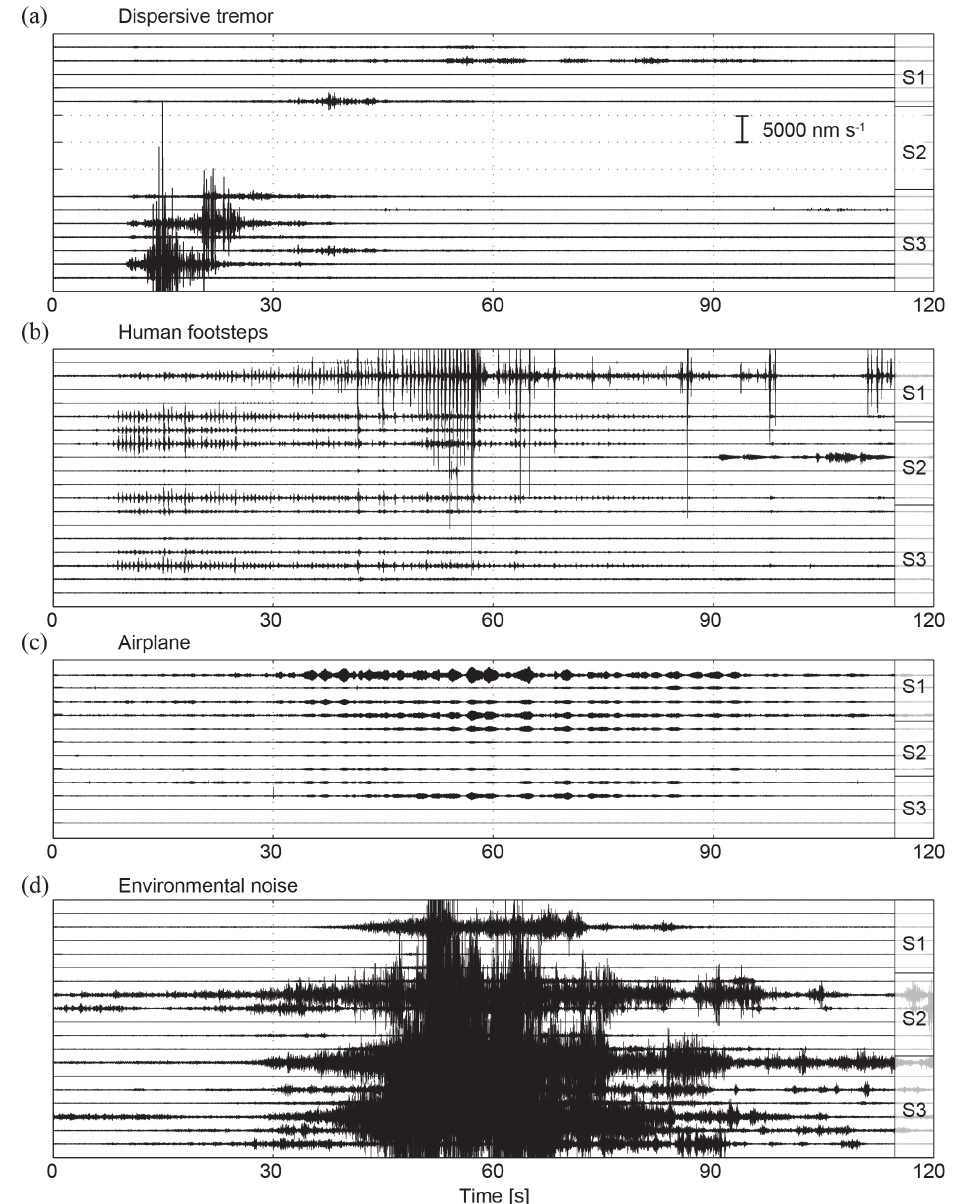
Figure 8. Vertical trace seismograms of long-duration tremor-like signals recorded at Super-Sauze and Pechgraben. A constant time and amplitude scale (indicated in a ) is applied. (a) Dispersive tremor, SZ10, t 0 4 July 2010, 00:45:20. (b) Human footsteps at short distances, SZ10, t 0 5 June 2010, 13:08:33. (c) Airplane, PG16, t 0 8 November 2016, 04:56:00. (d) Environmental noise, SZ10, t 0 9 June 2010,